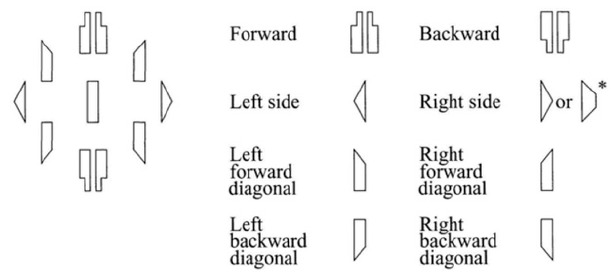
Figure 6. The eight main directions of Kinetography. Created by Ann Hutchinson Guest, used with permission from the author. permission from the